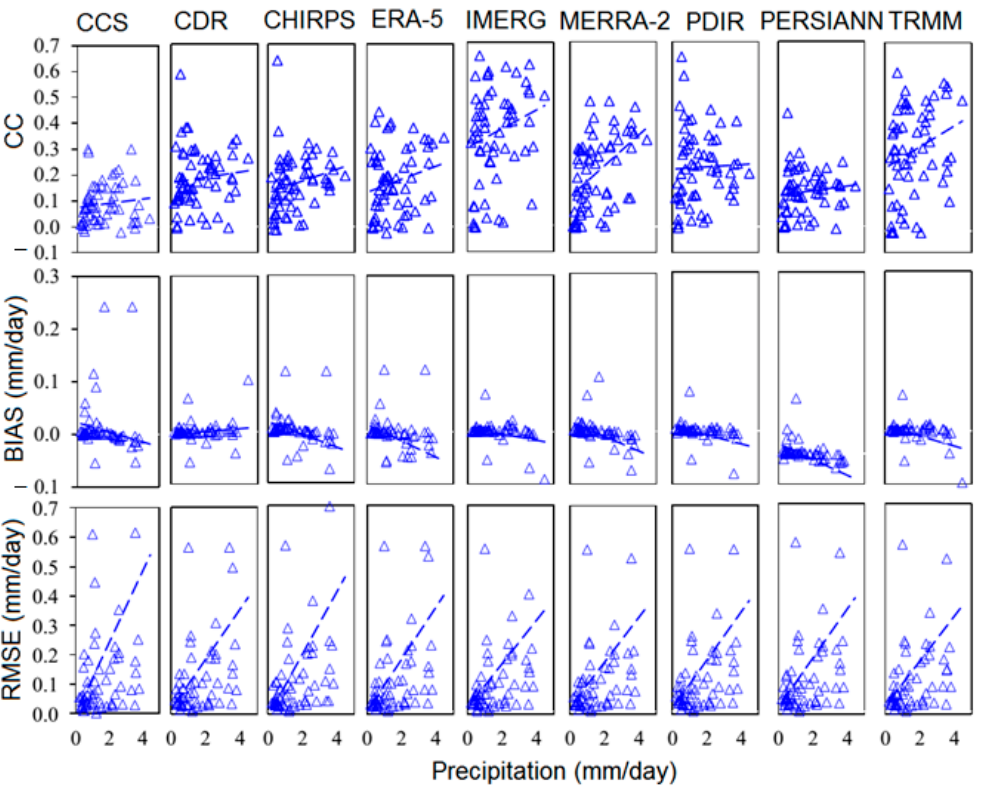
Figure 10. Influence of the rainfall intensity on the estimated values of Bias, CC, and RMSE for all precipitation products in Pakistan. Figure 15 illustrates the seasonal variability of rBias (%) determined for all SPPs and rea- nalysis products across the whole study domain. In the winter season, two products—CCS and PDIR—showed the best performance, as indicated by the lowest values of rBias for both prod- ucts. Conversely, CCS showed the worst performance in the spring season, with the highest overestimation value (rBias > 60%). In the summer season, all precipitation products revealed an underestimation of the precipitation amount. In this season, only two products (CHIRPS and MERRA-2) showed relatively acceptable values of rBias (<10%). ERA-5 showed a signifi- cant underestimation of the observed precipitation amount in all seasons, with the worst per- formance in the summer season (underestimation > 70%). Overall, CHIRPS product showed best performance in terms of relative bias, followed by IMERG.